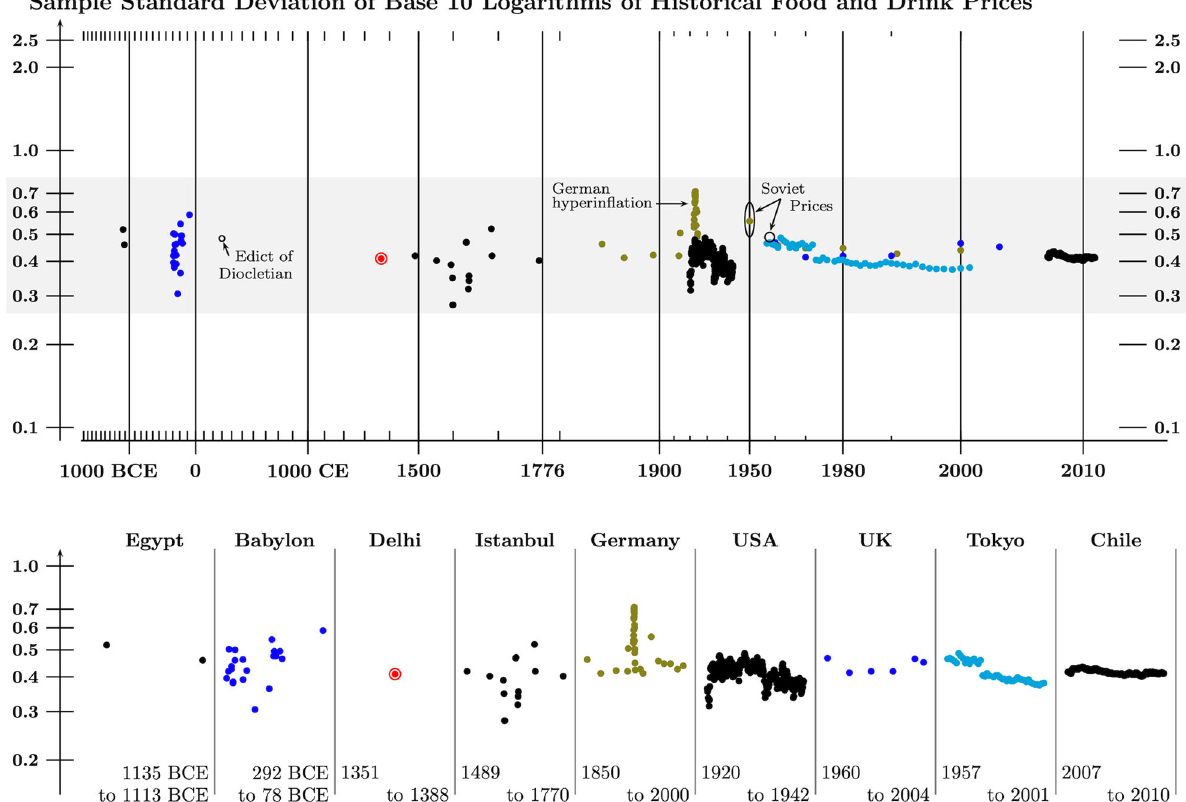
Fig. 2 Widths of distributions of log prices. Conservative estimates of the width of the distribution of log prices using data from different cultures and continents, covering three thousand years. The light grey band suggests a Goldilocks principle, of neither too much nor too little width. Note that the German hyperin fl ation data appear as a peak with a height of ~0.3, despite the fact that the underlying log prices increased by about 10.